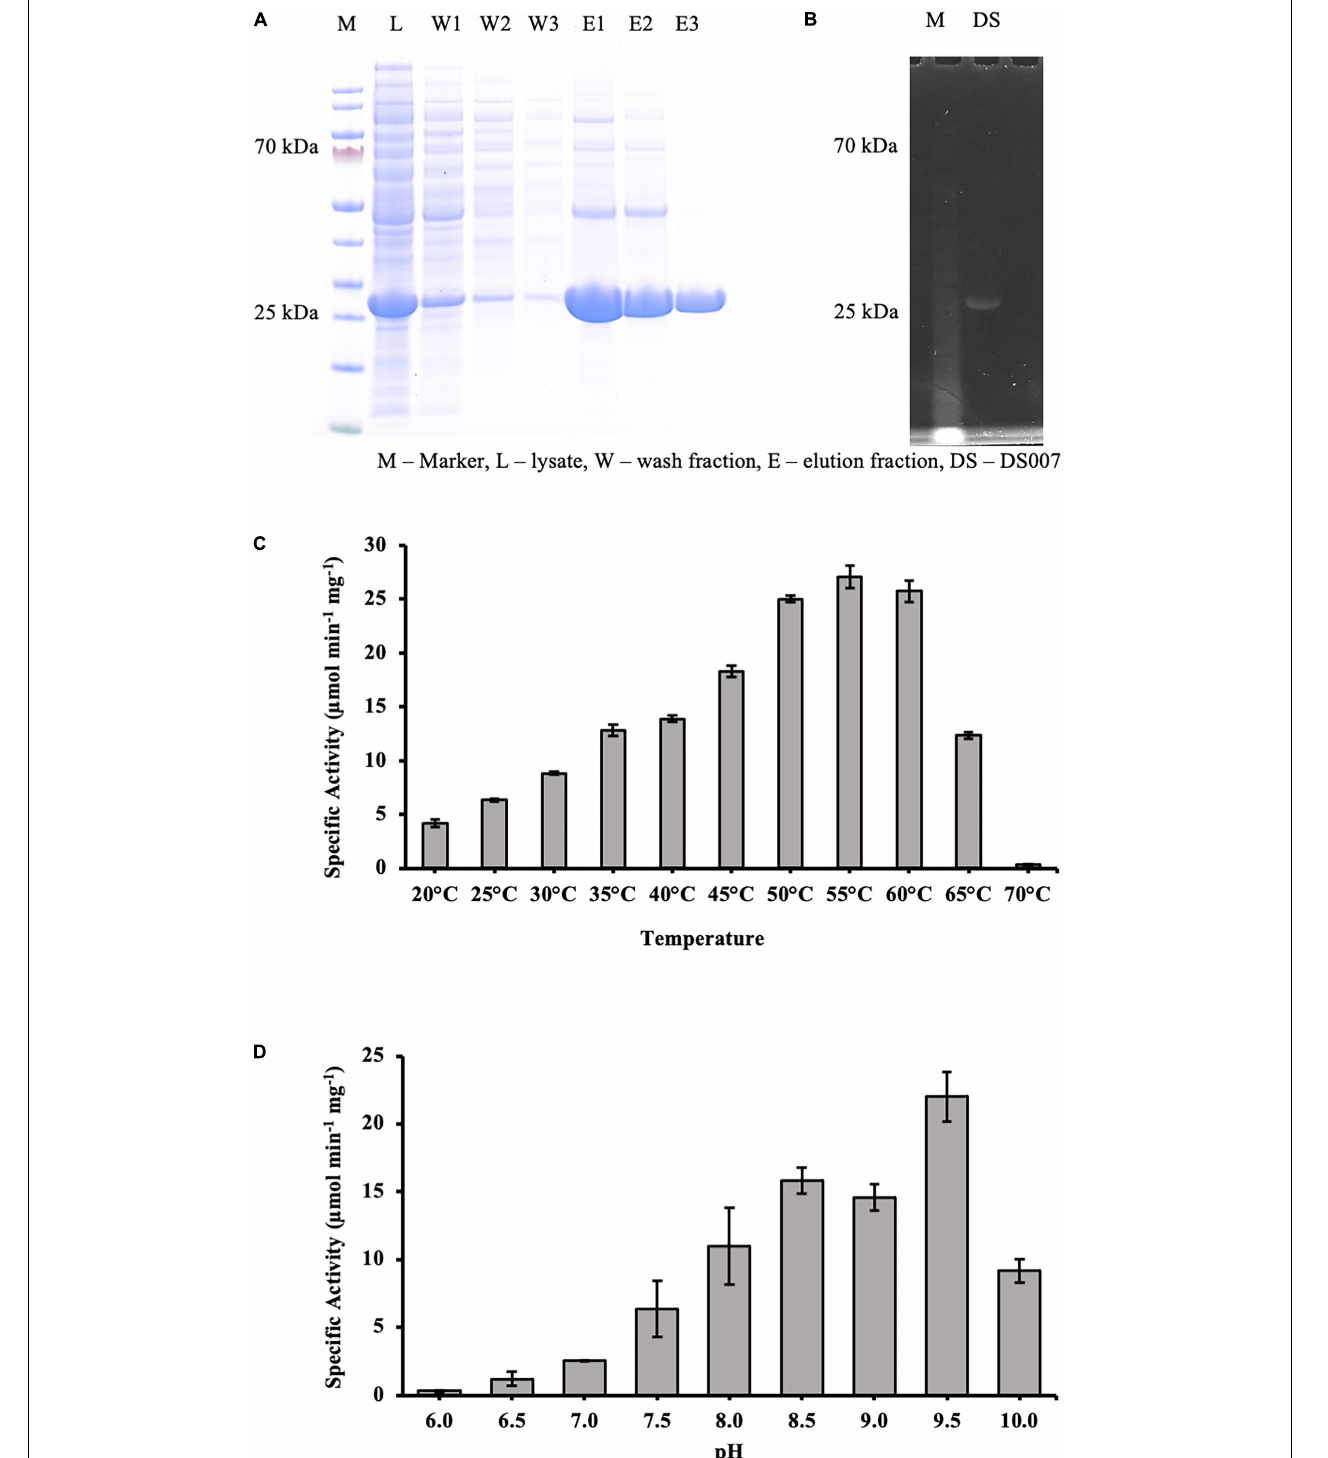
FIGURE 3 | (A) SDS-PAGE analysis showing the purification of DS-007 by Ni-NTA chromatography. The expected size of DS-007 is 24 kDa. (B) An in-gel activity assay with 4-methylumbelliferyl butyrate was carried out and the fluorescent band at the position of DS-007 verified its lipolytic activity. (C) The temperature optimum of DS-007 is 55 ◦ C. (D) pH optimum was observed to be at 9.5. However, DS-007 showed good activity between pH 8 and pH 9.5. pH values lower than 7.5 resulted in a drastic loss of activity. (A,B) Show representative results, (C,D) the average and standard deviation from 3 independent experiments.